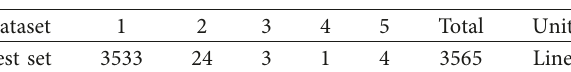
Table 5: Test dataset.